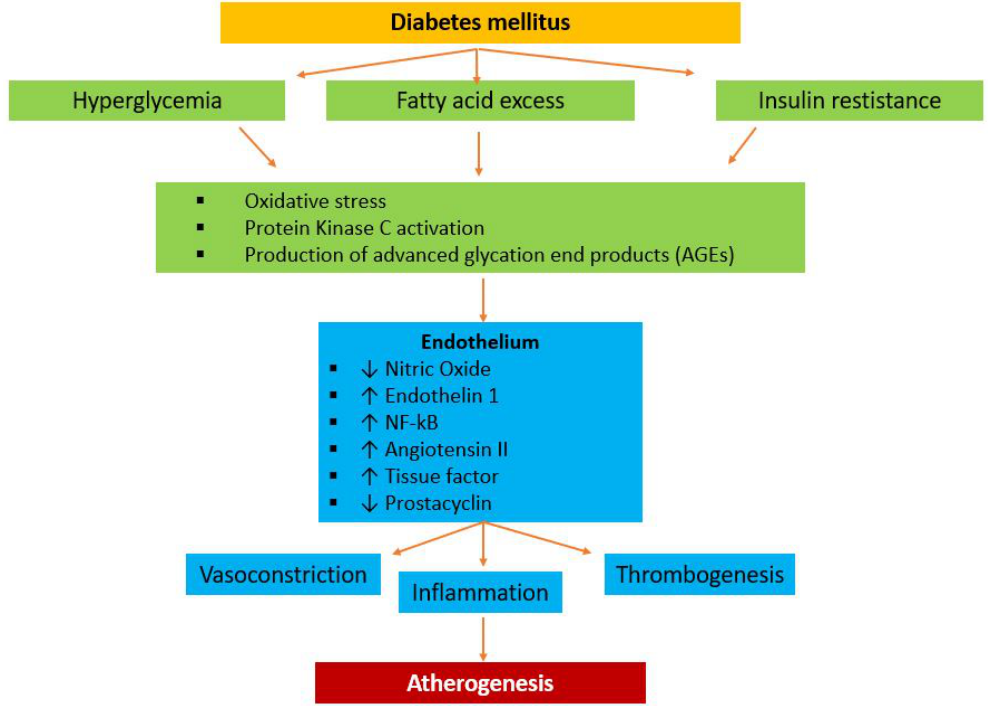
Figure 3. Pathophysiology of atherogenesis in patients affected by diabetes mellitus. In diabetes, the combination of hyperglycemia, free fatty acid excess, and insulin resistance leads to several systemic effects, including increasing oxidative stress, protein kinase C, and production of advanced glycation end products. The activation of these systems impairs endothelial function, through the decreasing of nitric oxide and prostacyclin and the increasing of endothelin 1, NF- κB, angiotensin II, and tissue factor. These pathways cause vasoconstriction, increase inflammation, promote thrombosis, and, thus, contribute to atherogenesis. AGEs: advanced glycation end products.